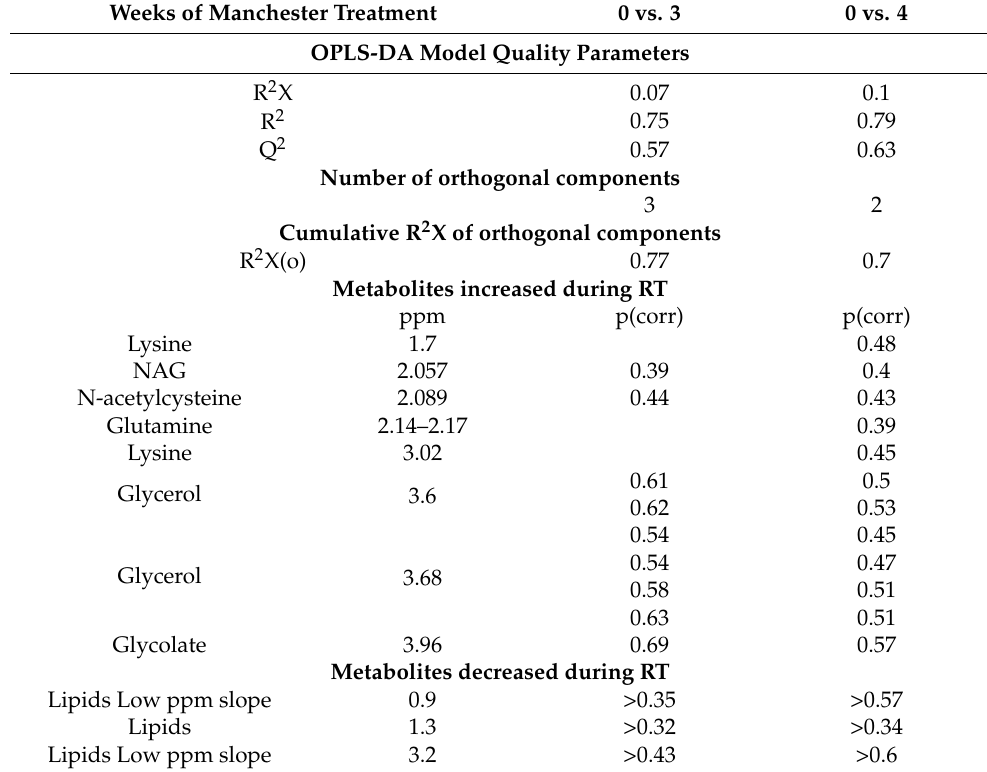
Table 3. Results from the OPLS-DA analysis of the blood serum metabolic profile changes occurring during radiotherapy of the patients receiving Manchester fractionated radiotherapy (RT). Weeks of Manchester Treatment 0 vs. 3 0 vs.